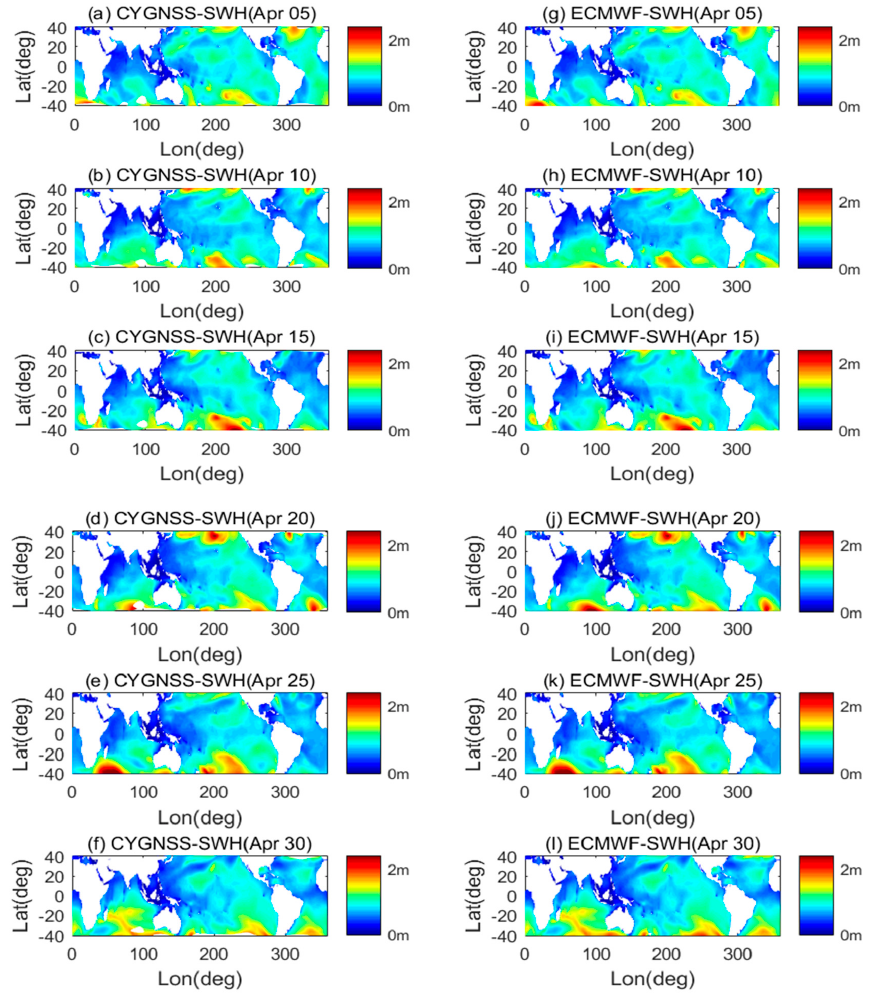
Figure 7. The CYGNSS SWH estimate (left) and ECMWF model SWH value (right) in April 2017.